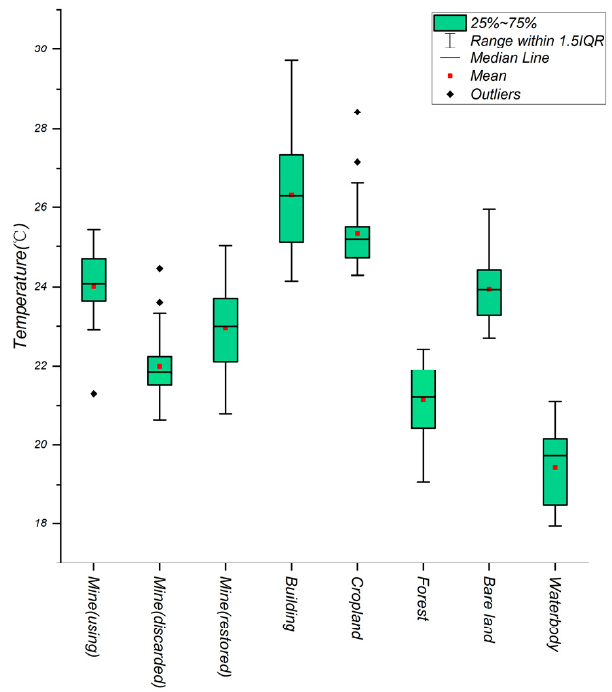
Figure 6. Land surface temperature statistics of different land type.